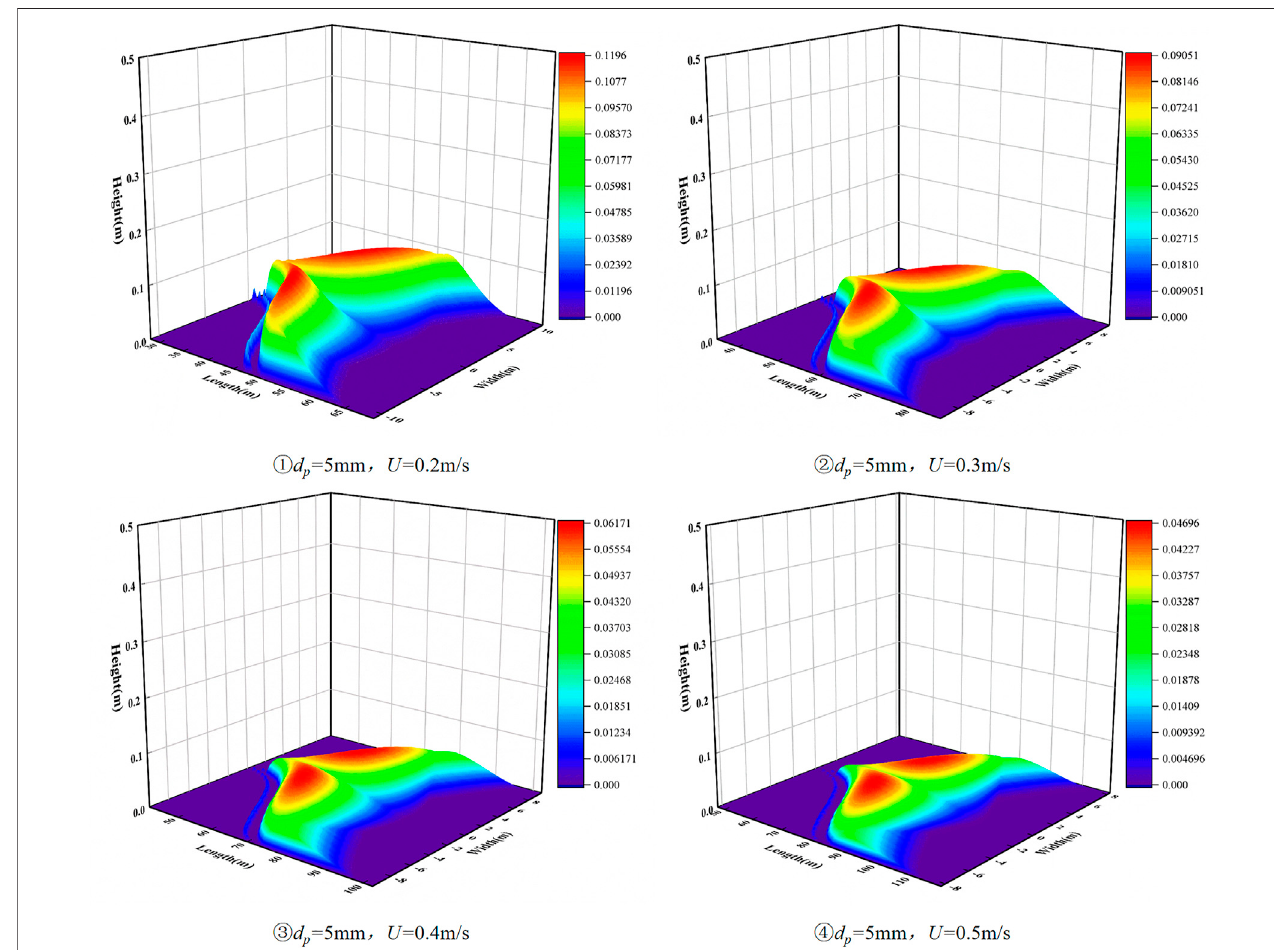
FIGURE 12 | Variation of sedimentary bed morphology distribution with fl ow